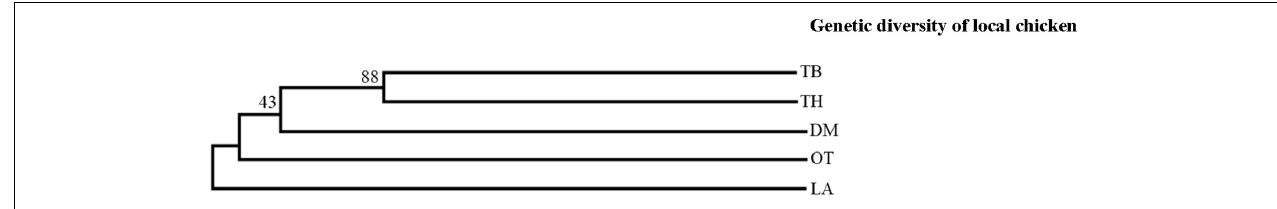
FIGURE 3 | The unweighted pair-group method using arithmetic averages (UPGMA) dendrogram summarizing the standard genetic distances ( Ds ) between village-based populations. The numbers at the nodes are the percentage bootstrap values after 1,000 replications over loci.